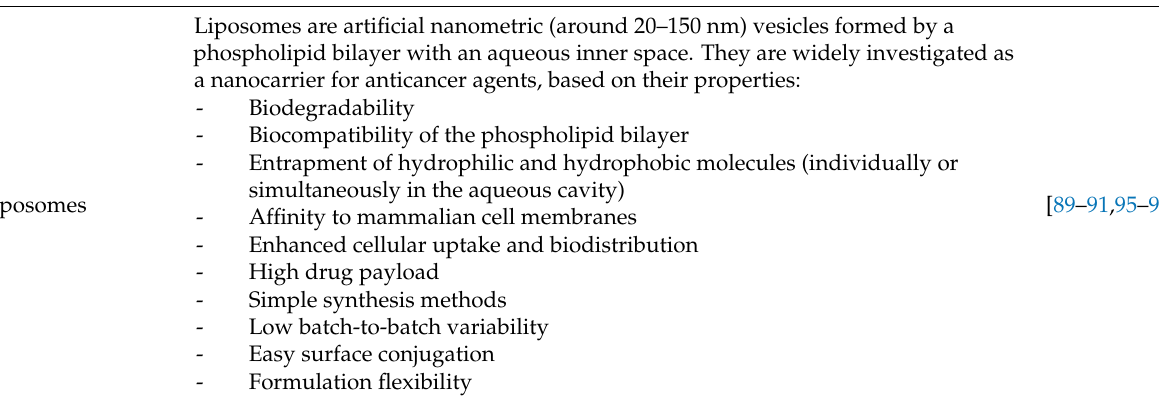
Metallic and metal oxide